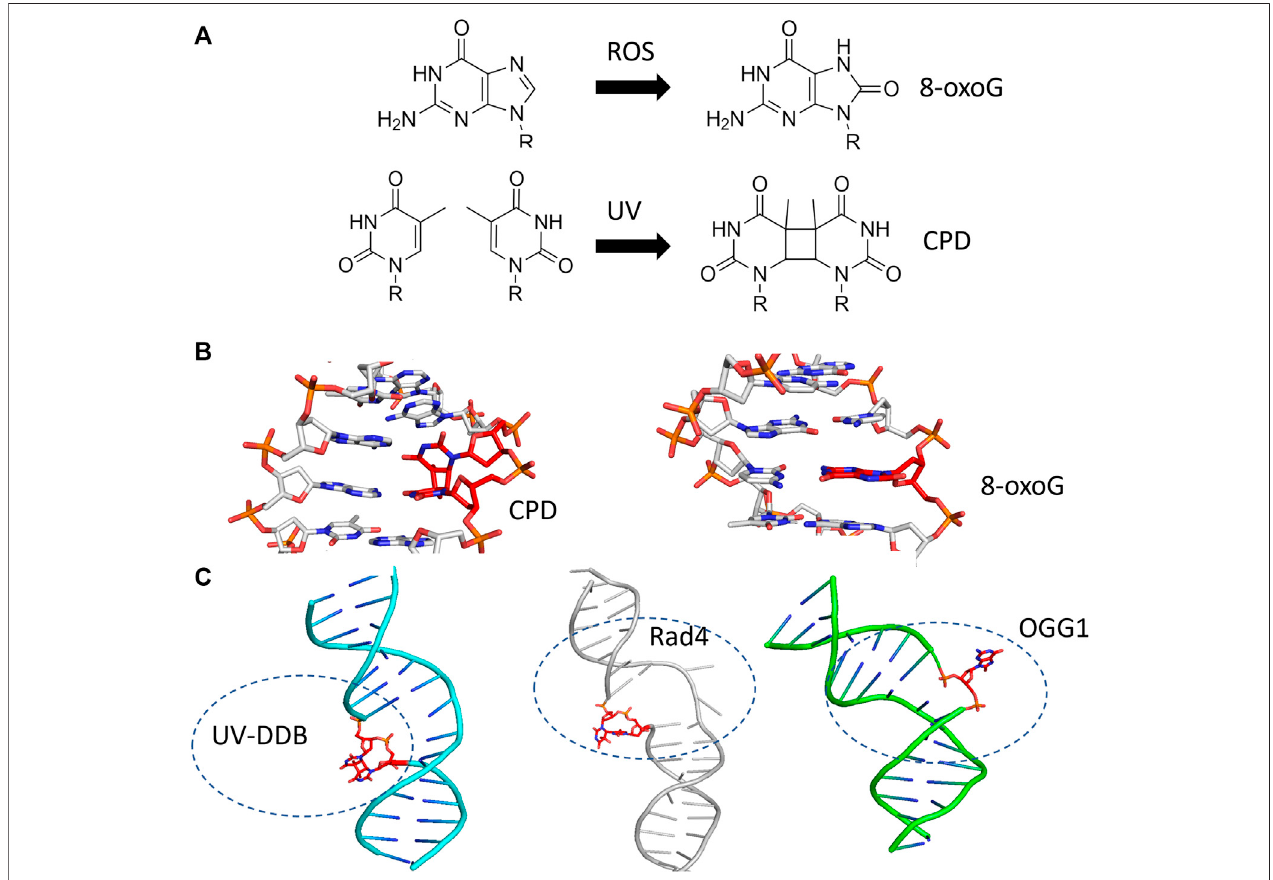
FIGURE 3 | BER and NER substrates distort duplex DNA structure and are fl ipped out by damage detection proteins. (A) The formation of 8-oxoguanine by reactive oxygen species (ROS, top) and cyclobutane pyrimidine dimers by ultraviolet light (UV, bottom) generates substrates that largely resemble their undamaged counterparts. (B) The presence of 8-oxoG or CPD in duplex DNA mildly perturbs the structure of duplex DNA. Protein Data Bank (PDB) IDs: 183D and 1N4E used from (Lipscomb et al., 1995; Park et al., 2002) (C) When damage is bound by a damage detection protein, the structure exhibits DNA bending with the damage fl ipped outside of the DNA helix. Co-complexes are shown with the protein removed for UV-DDB binding CPD [cyan cartoon, PDB ID: 4A09 from (Fischer et al., 2011)], Rad4- Rad23 binding a 6-4 photoproduct [gray cartoon, PDB ID: 6CFI from (Paul et al., 2019)], and OGG1 binding 8-oxoG [green cartoon, from PDB ID:1EBM (Bruner et al., 2000)]. In each case, the DNA damage is indicated with red